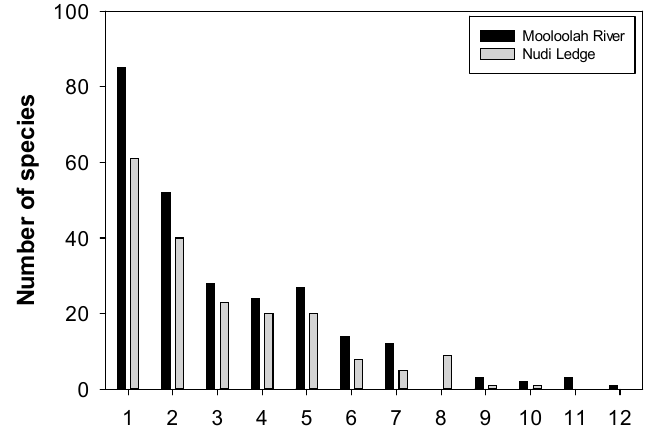
Figure 3. Distributions for species abundance using octaves (abundance bins based on log 2 abundance) for heterobranch sea slugs at 2 sites on the Sunshine Coast, Qld. Table 1. Cut-off values (in quartiles—increments of 25%) for measures of numerical rarity, including number (percent) of species falling into each category for ( A ) the quartile method, and ( B ) the octave method based on log 2 bins. Percentages rounded to nearest whole number.